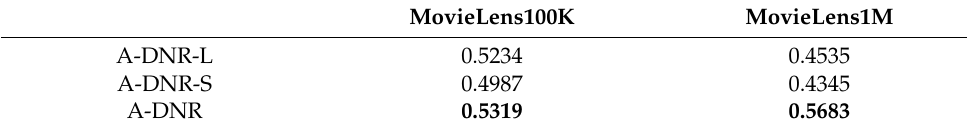
Table 6. The impact of user long-term and short-term preferences on NDCG@10.